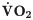
Abbreviations: CE-ARM, continuous exercise with mask; CE, continuous exercise without mask; PETCO2, Partial pressure of end tidal CO2; PETO2, Partial pressure of end tidal O2; RR, Respiratory rate; V˙O2, Oxygen uptake and VE, Ventilation. Data expressed in Mean (Standard Deviation). † denotes a significant difference between conditions (CE x CE-ARM) identified by the Post Hoc (p <0.05). ∞ Denotes main effect of time identified by ANOVA (p <0.05).The dashed line indicates the maximum mean value reached in the incremental test.